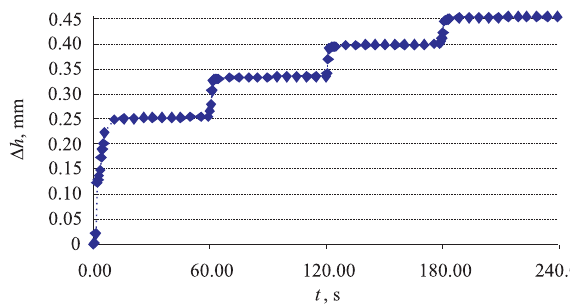
Fig. 4. Δ h vs. time during test process for Sample 1